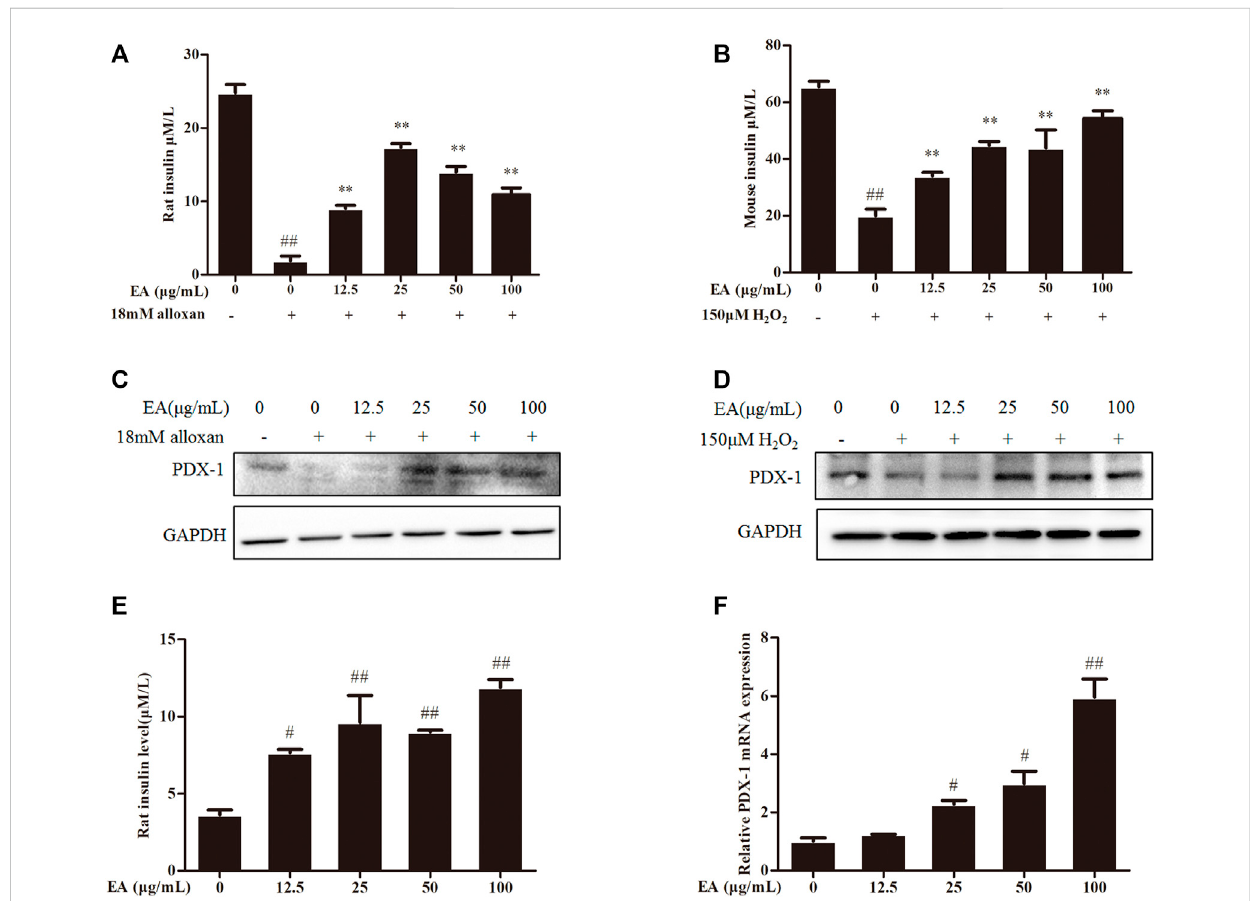
FIGURE 4 EAincreasesinsulinsecretion via enhancingPDX-1expression.INS-1cellswereincubatedwithEA(12.5 – 100 μ g/mL)andalloxanfor24 h.MIN6cells were incubated with EA (12.5 – 100 μ g/mL) and H 2 O 2 for 24 h (A,B) Effect of EA on KCl-stimulated insulin secretion in INS-1 cells and MIN6 cells under oxidativestress-inducedtoxicitywasdetectedusingELISA. (C,D) EffectofEAonproteinexpressionofPDX-1inINS-1cellsandMIN6cellsunderoxidative stress-inducedtoxicitywasdetectedbywesternblotting. (E) EffectofEAonbasalglucose-stimulatedinsulinsecretioninINS-1cellswasdetermined by ELISA. (F) Effect of EA on mRNA expression of PDX-1 in INS-1 cells was detected by qPCR. Data are the mean ± SEM. n = 3. # p < 0.05 compared with control, ## p < 0.01 compared with control, * p < 0.05 compared with the OS-model group, ** p < 0.01 compared with the OS-model